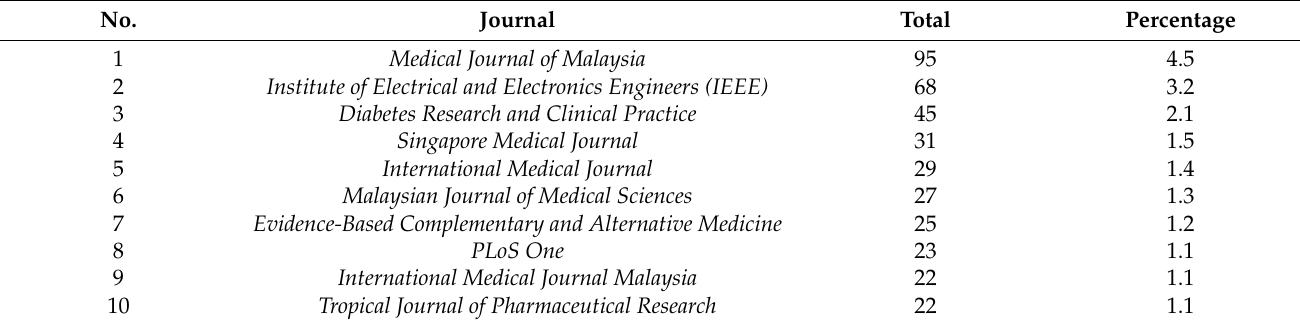
Table 3. Top 10 sources of diabetes research output productivity in Malaysia.